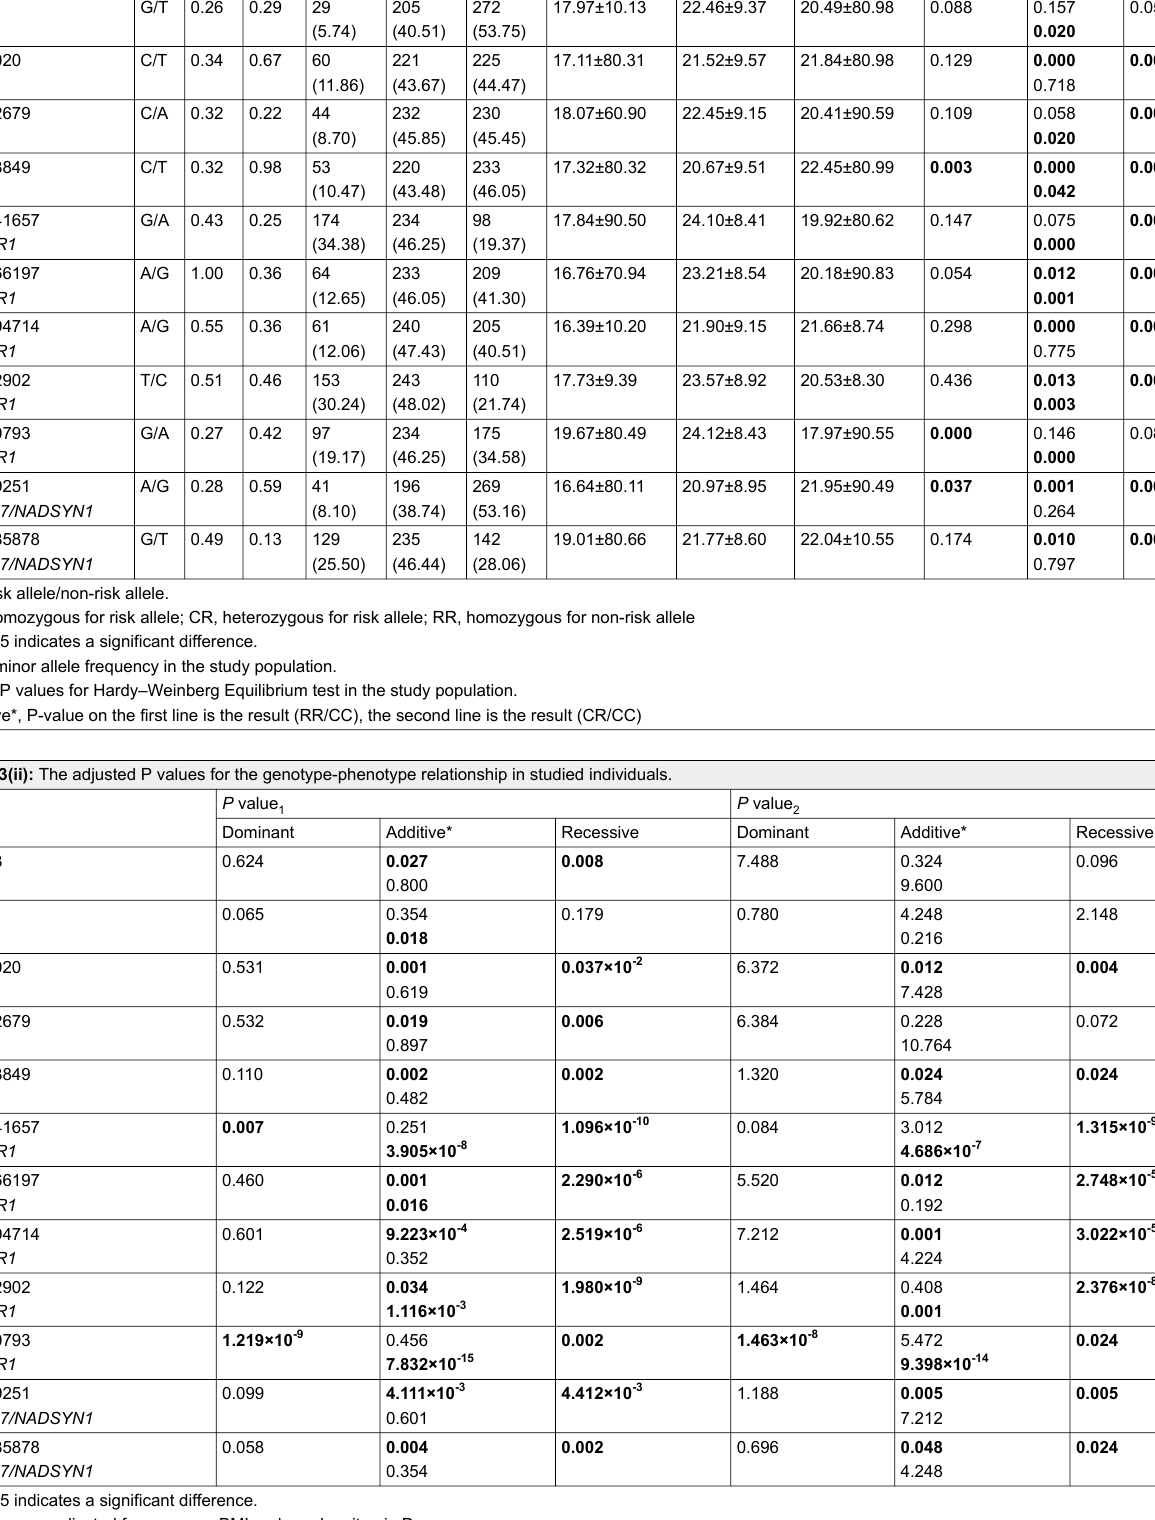
Table 3(i): The association between genotypes and 25(OH)D concentrations in studied individuals. Subjects n (%) mean 25(OH)D(ng/ml) P valueSNP A/a MAF HWE CR RR Dominant Additive* Recessive